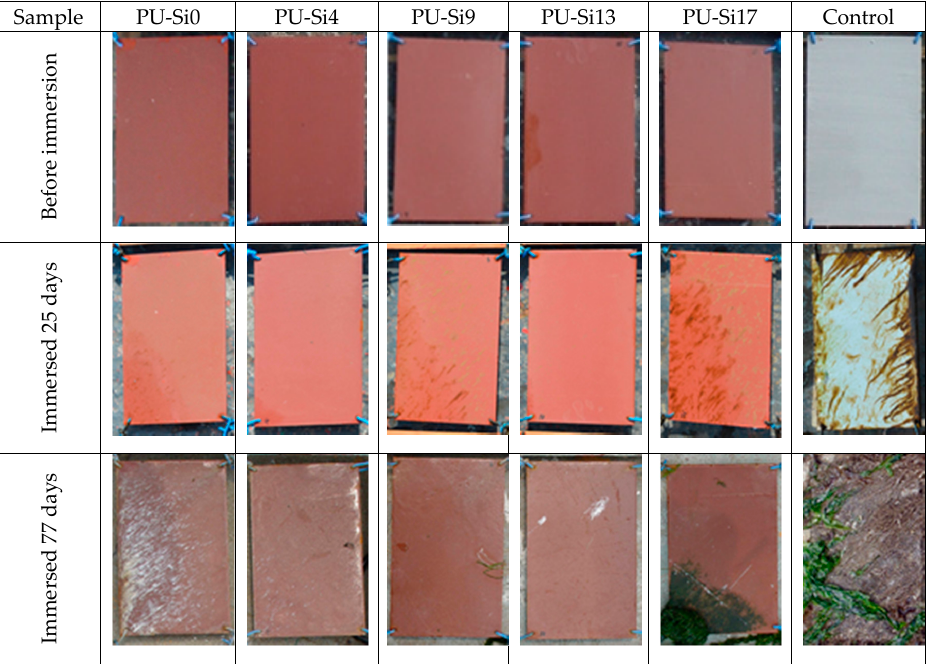
Figure 18. Photographs of panels immersed in the Yellow Sea, China.